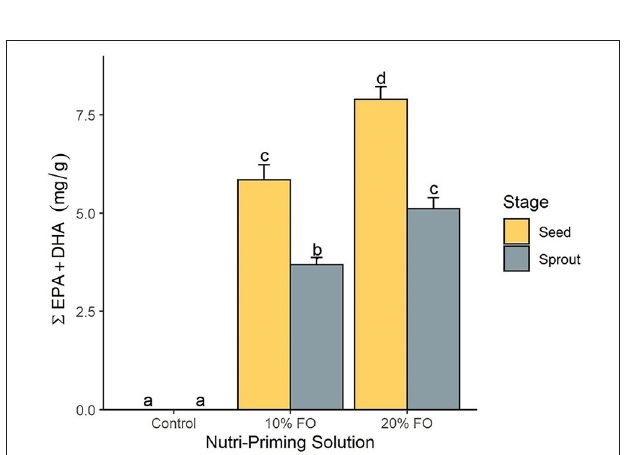
FIGURE 2 | The total content of EPA and DHA (mg per g of sample) by nutri-priming solution and plant stage. Values are expressed as mean and standard error. Means without a common letter differ ( P < 0.05).